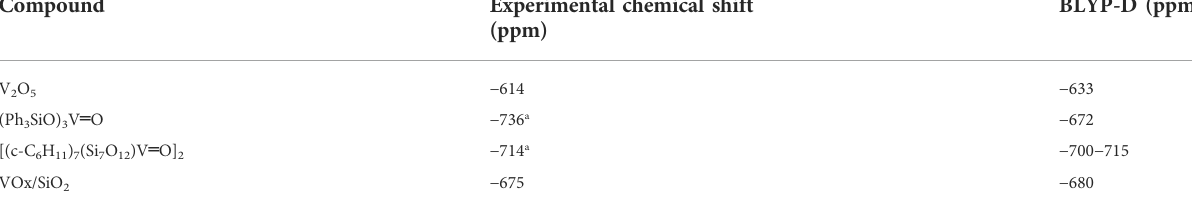
TABLE 2 Comparison of experimental and calculated vanadium chemical shifts of model compounds.